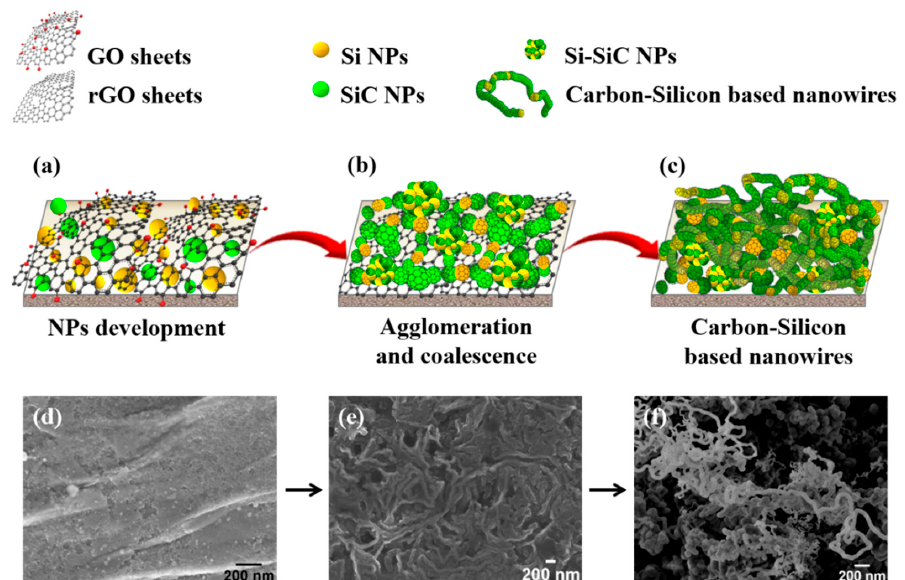
Figure 5. Scheme of the proposed mechanism for the carbon–silicon-based nanowires formation. ( a ) Si-based nanoparticle development at the interface GO and Si wafer. ( b ) nanoparticle agglomeration and coalescence into larger structures. ( c ) carbon-silicon based nanowires formation. FE-SEM images to support the proposed steps ( d ) development. ( e ) agglomeration and coalescence and ( f ) carbon-silicon based nanowires